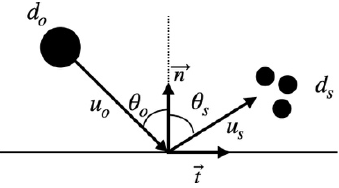
Figure 2. Main splashing parameters related to the numerical models.